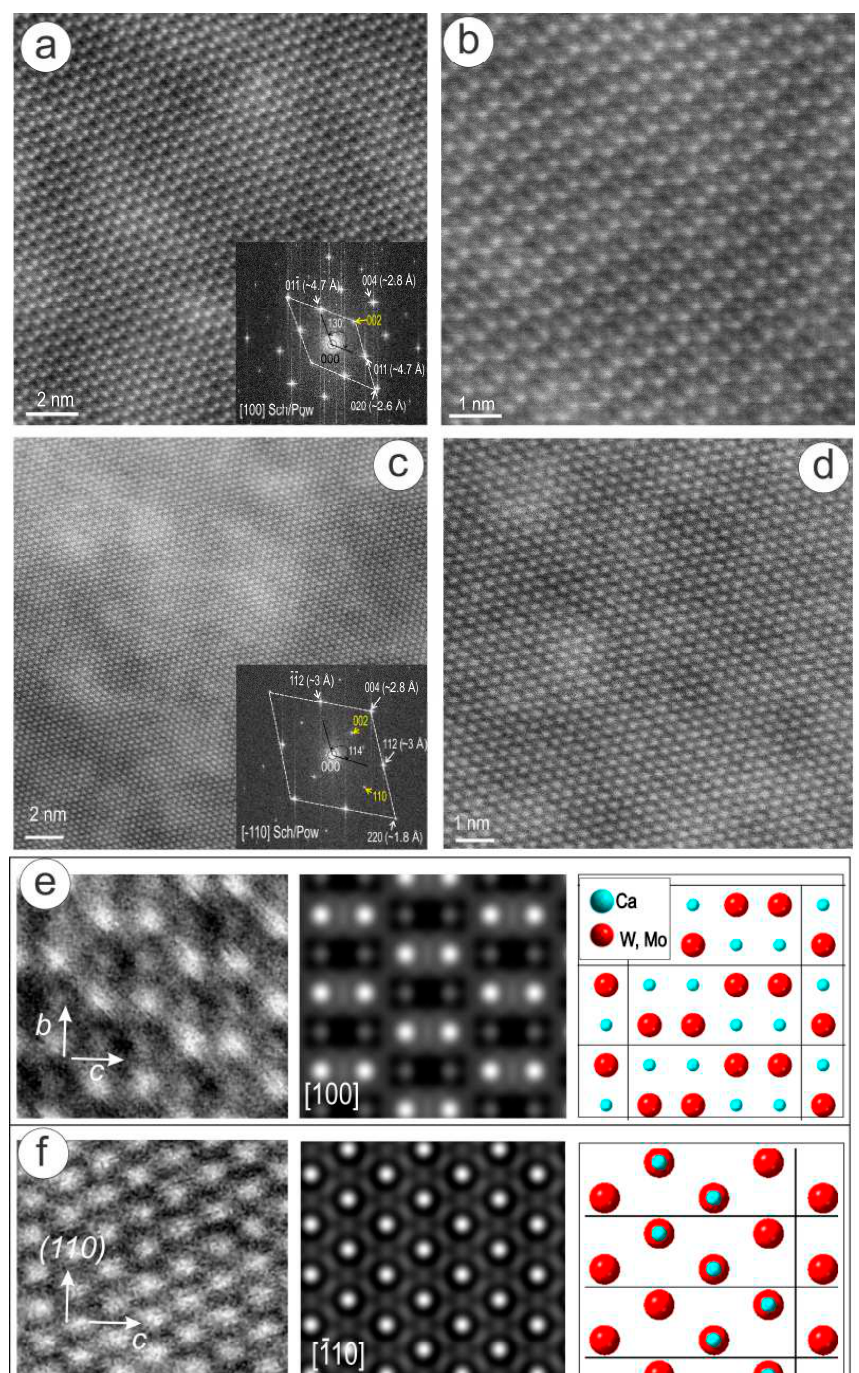
Figure 12. HAADF STEM images ( a – d ) showing atomic arrangements in scheelite-powellite on zone axes as marked on FFTs (insets). ( e , f ) From left to right, HAADF image, STEM simulation, and crystal model for the [100] and [1(cid:3364)10] zone axes (imaged in a – d ). Note the good fit between the images and simulation in each case. The bright spots on the HAADF images can be attributed in agreement with the crystal models. Crystal structures from Hazen et al. [2]. Unit cells for scheelite and powellite: a = 5.2429 Å, c = 11.3737 Å; and a = 5.222 Å, c = 11.425 Å, respectively; space group I 4 1 / a in both cases.